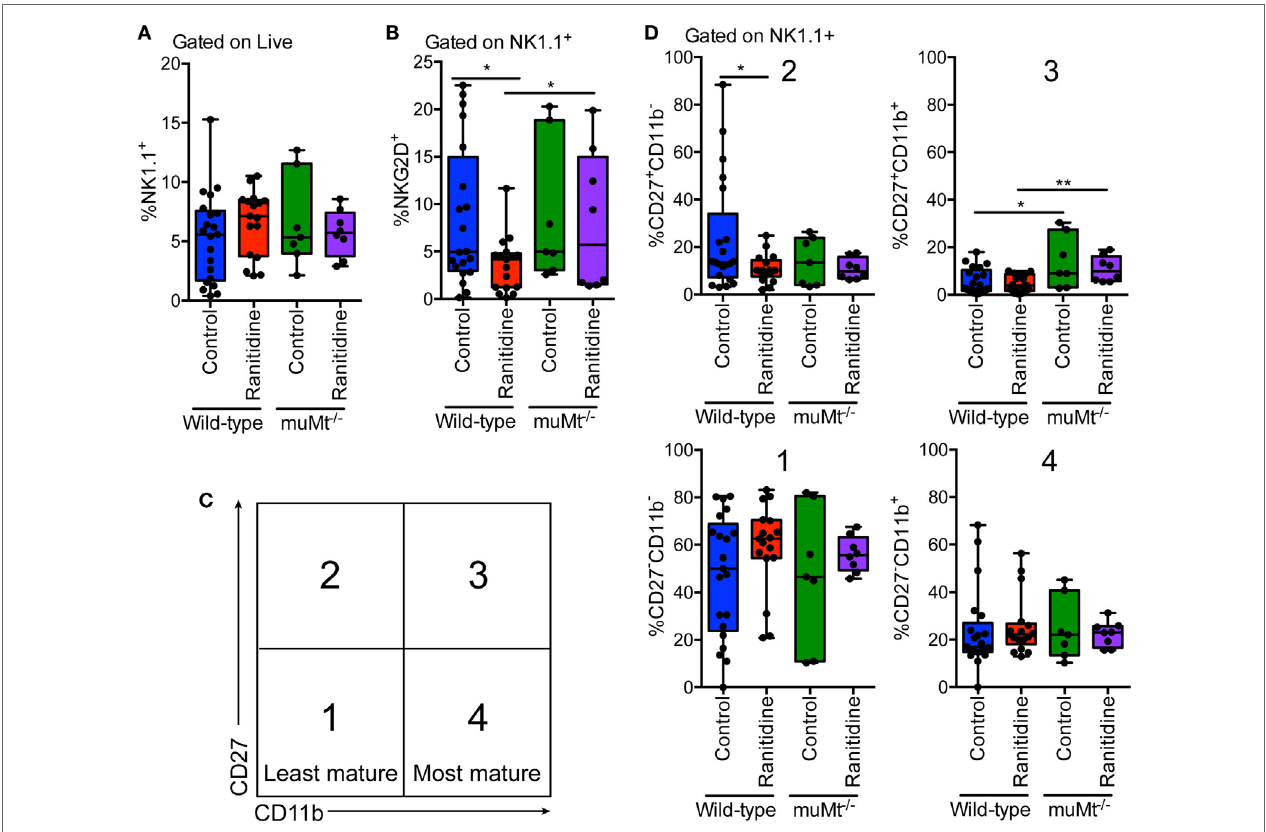
FigUre 7 | NK cell maturation and NKG2D expression was significantly altered in wild-type E0771-GFP tumor-bearing mice with ranitidine treatment, but not in muMt − / − B cell-deficient mice. Spleens were isolated from tumor-bearing wild-type and B cell-deficient C57BL/6 mice (ranitidine-treated and control) and stained